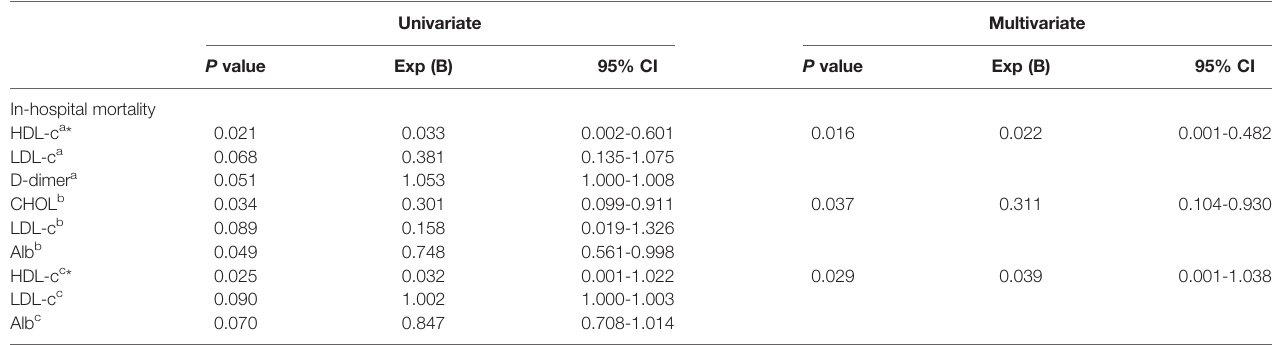
TABLE 4 | Univariate and multivariate analysis for factors associated with in-hospital